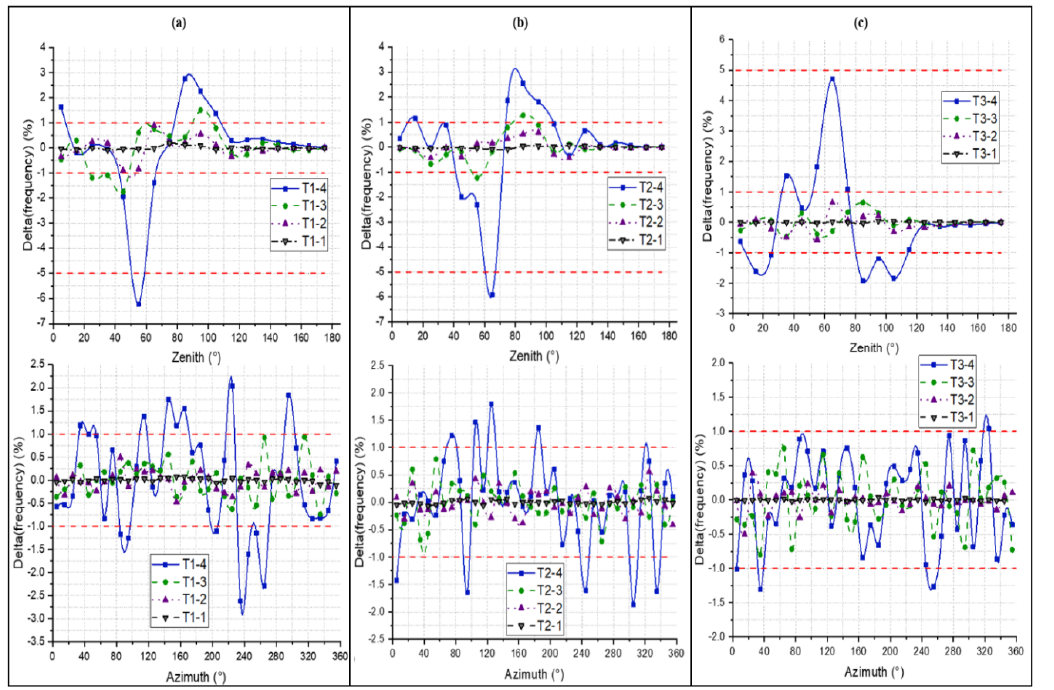
Figure 6. Delta frequencies for leaf zenith angles (first row) and azimuth angles (second row) of the various structures, ( a ) first stage, ( b ) second stage, and ( c ) last stage. For each stage, the last indices refer to the decimation rate (1: 50%, 2: 0.2%, 3: 0.05%, and 4: 0.01%). This annotation will be used henceforth.